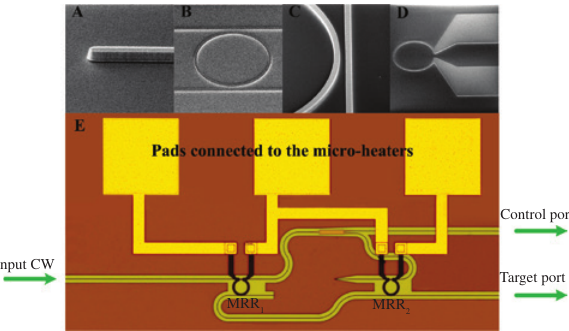
Figure 2: Scanning electronic micrograph (SEM) of (A) the spot size converters (SSC), (B) the parallel MRR, (C) the gap between ring waveguide and straight waveguide, and (D) Ω -shaped TiN micro- heater. (E) Micrograph of the fabricated optical Feynman gate.